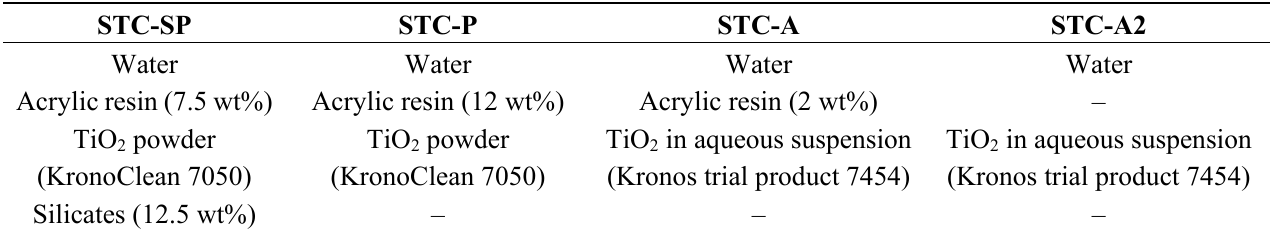
Table 1. Formulation of semi-transparent coatings. STC: semi-transparent